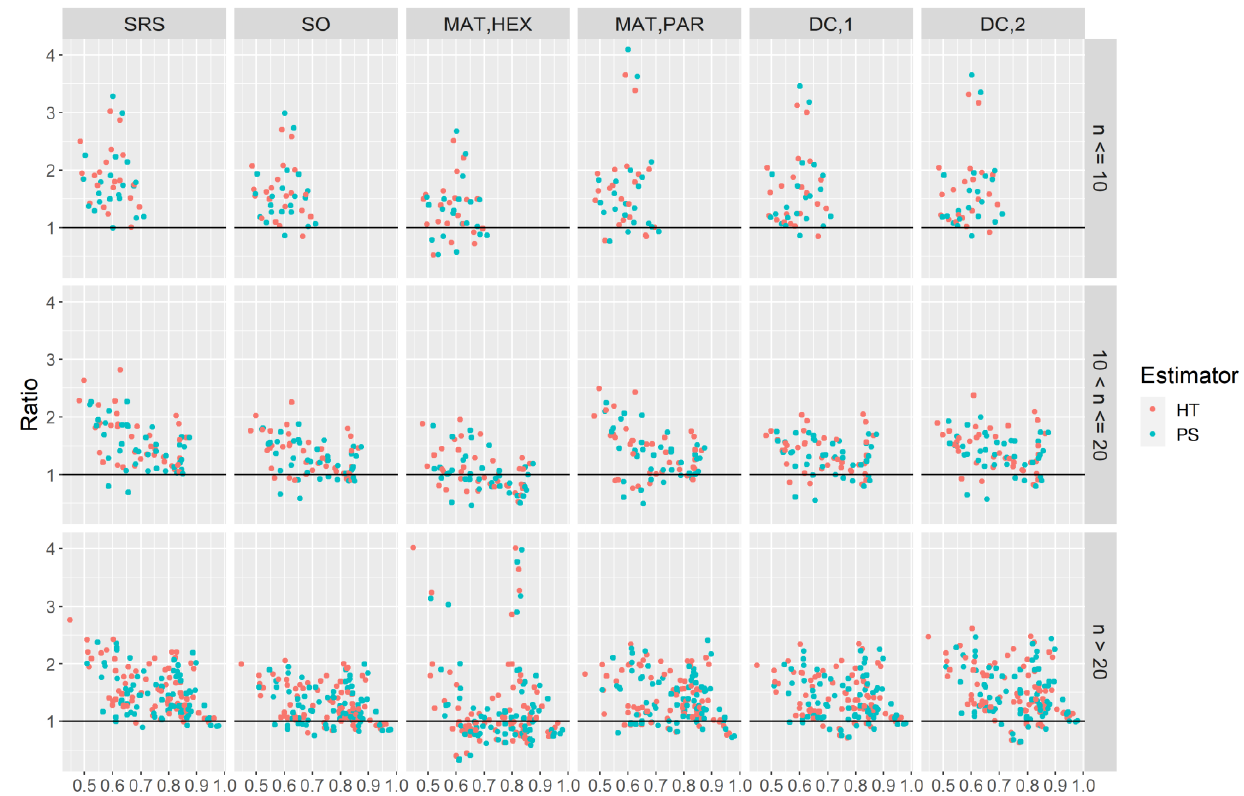
Figure 7. 𝑅𝑎𝑡𝑖𝑜̅̅̅̅̅̅̅̅ for all estimators disaggregated by the small domain size sample class under the HT and PS point esti- mators.